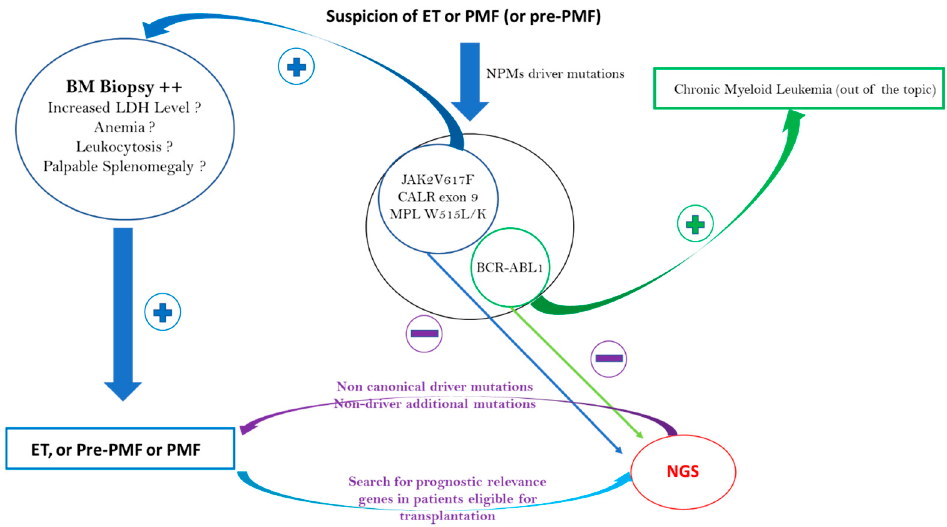
Figure 2. ET, pre-PMF, and PMF diagnostic approaches: NGS contribution to